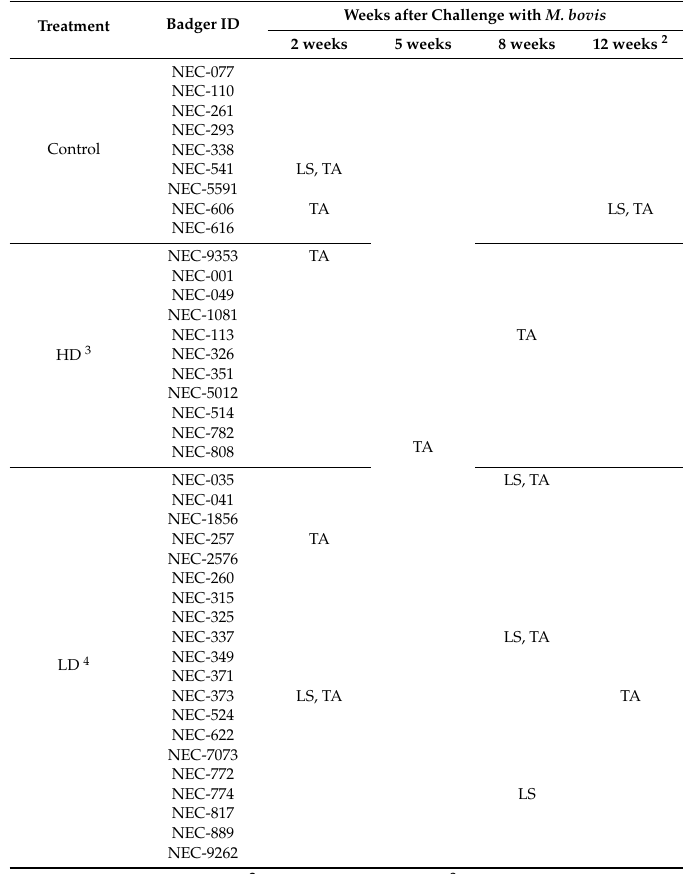
Table 8. Clinical samples from VES9 that yielded a positive M. bovis culture 1 .